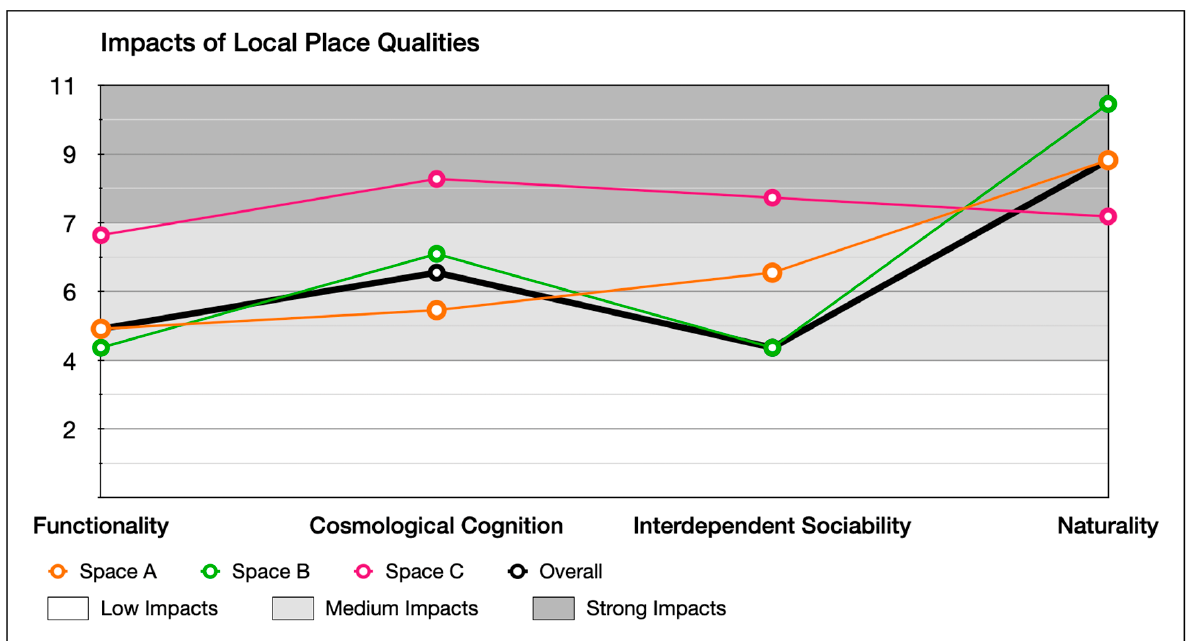
Figure 13. Comparison of impact score of indicators of local place qualities in different types of space.